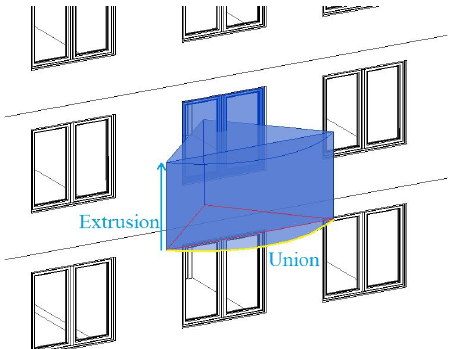
Figure 4 . Overlooking modelled by using CSG and extrusion modelling approaches.